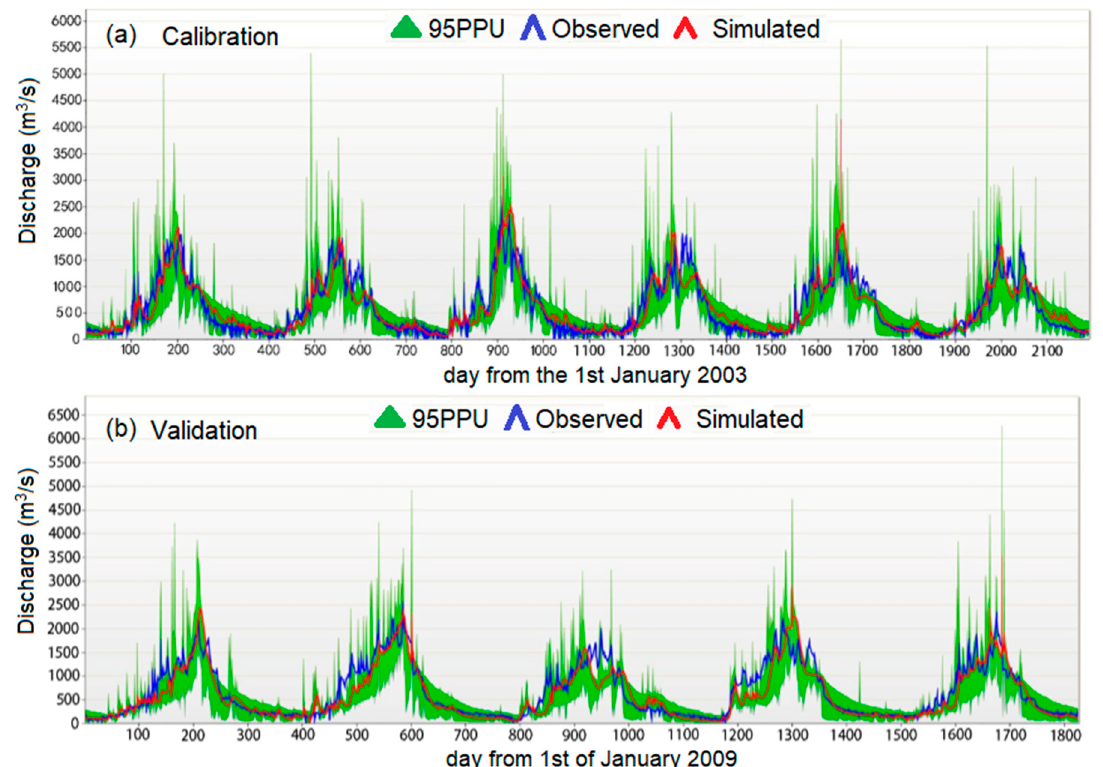
Figure 8. ( a ) Daily calibration (2003–2008) and ( b ) validation (2009–2013) using elevation band (EB) method in the application of the SWAT—CUP tool to the Darband discharge station in the Vakhsh River Basin in Central Asia. The observed discharge data (blue lines) are presented along with the prediction uncertainty (green range) and a set of 1000 simulations (red lines). 95PPU: 95% prediction uncertainty.